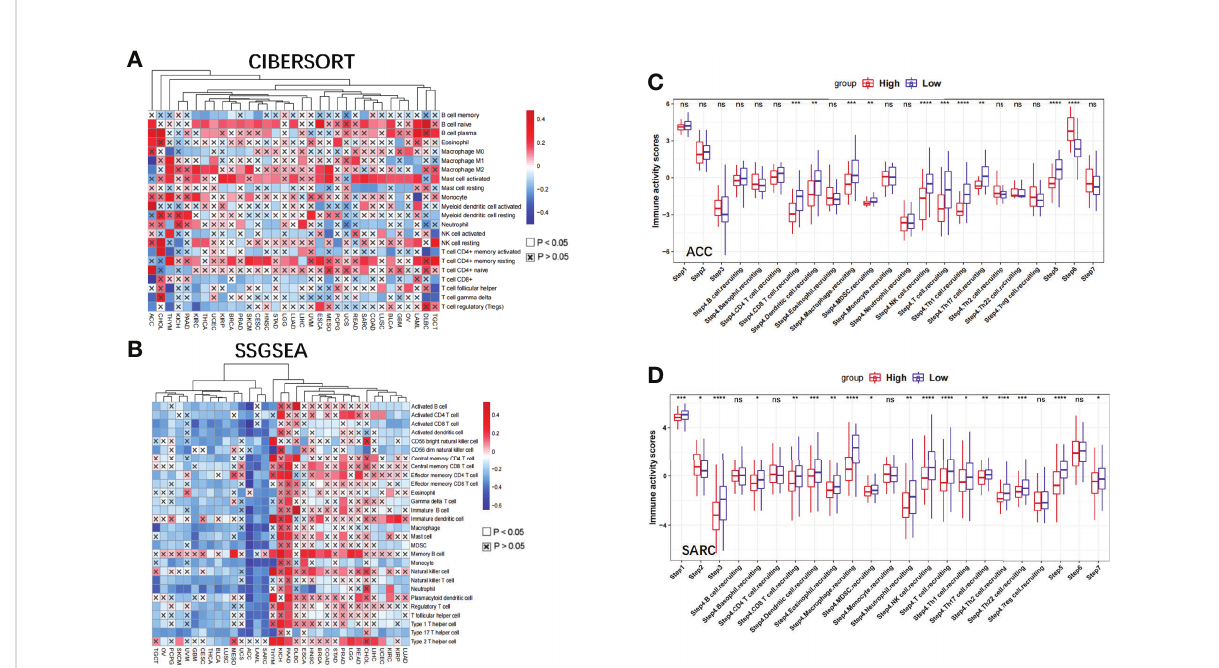
FIGURE 6 The effect of NBPF1 on immunological status in human cancers. (A) Correlation analysis between NBPF1 expression and the abundance of tumor-in fi ltrating lymphocytes in human cancers using the CIBERSORT algorithm. (B) Correlation between NBPF1 and 28 tumor-associated immune cells using the ssGSEA algorithm. (C, D) Comparison between groups with high and low NBPF1 expression in the various stages of the cancer immune cycle in ACC and SARC (*P < 0.05; **P < 0.01; ***P < 0.001; ****p < 0.0001; ns, no signi fi cant